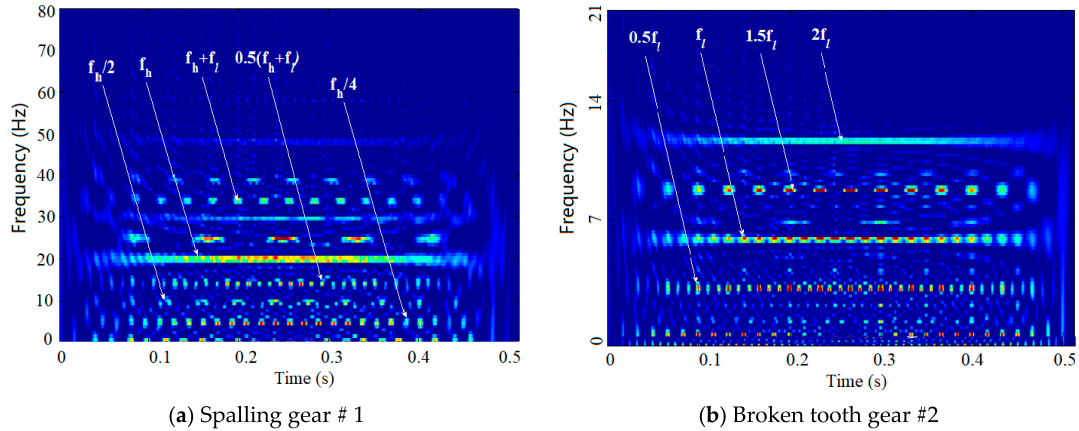
Figure 9. Two independent sources separated by nonlinear ICA with spalling gear #1 and broken tooth gear #2.